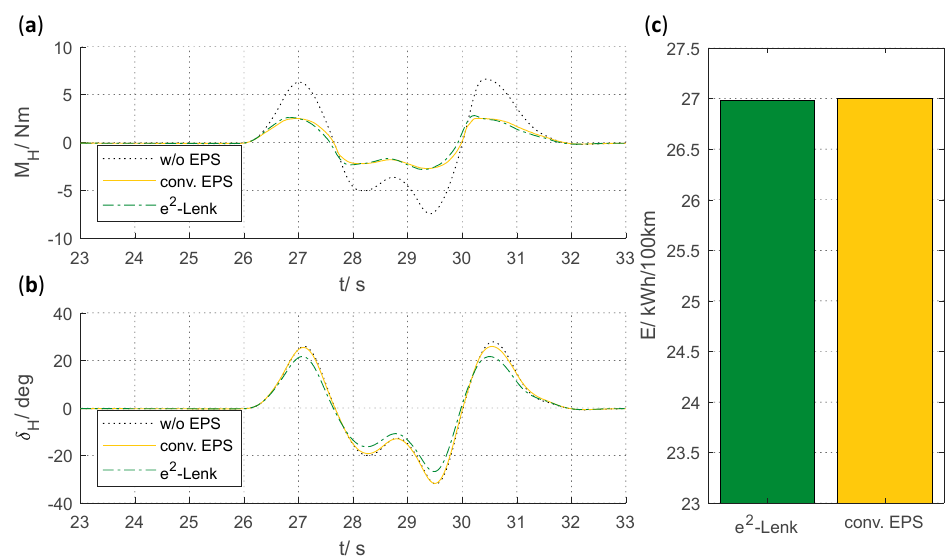
Figure 8. Double lane change: ( a ) dynamic response of steering wheel torque, ( b ) dynamic response of steering wheel angle and ( c ) comparison of each suspension with a conventional EPS regarding energy.